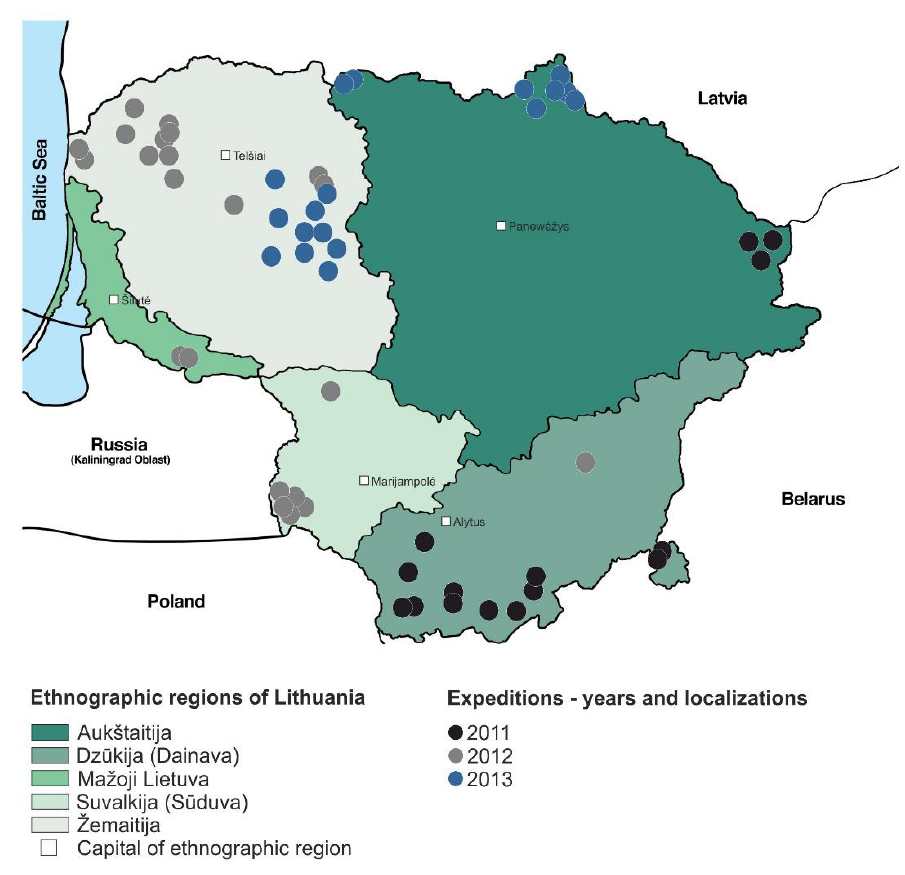
Figure 1. Ethnographic regions of Lithuania.